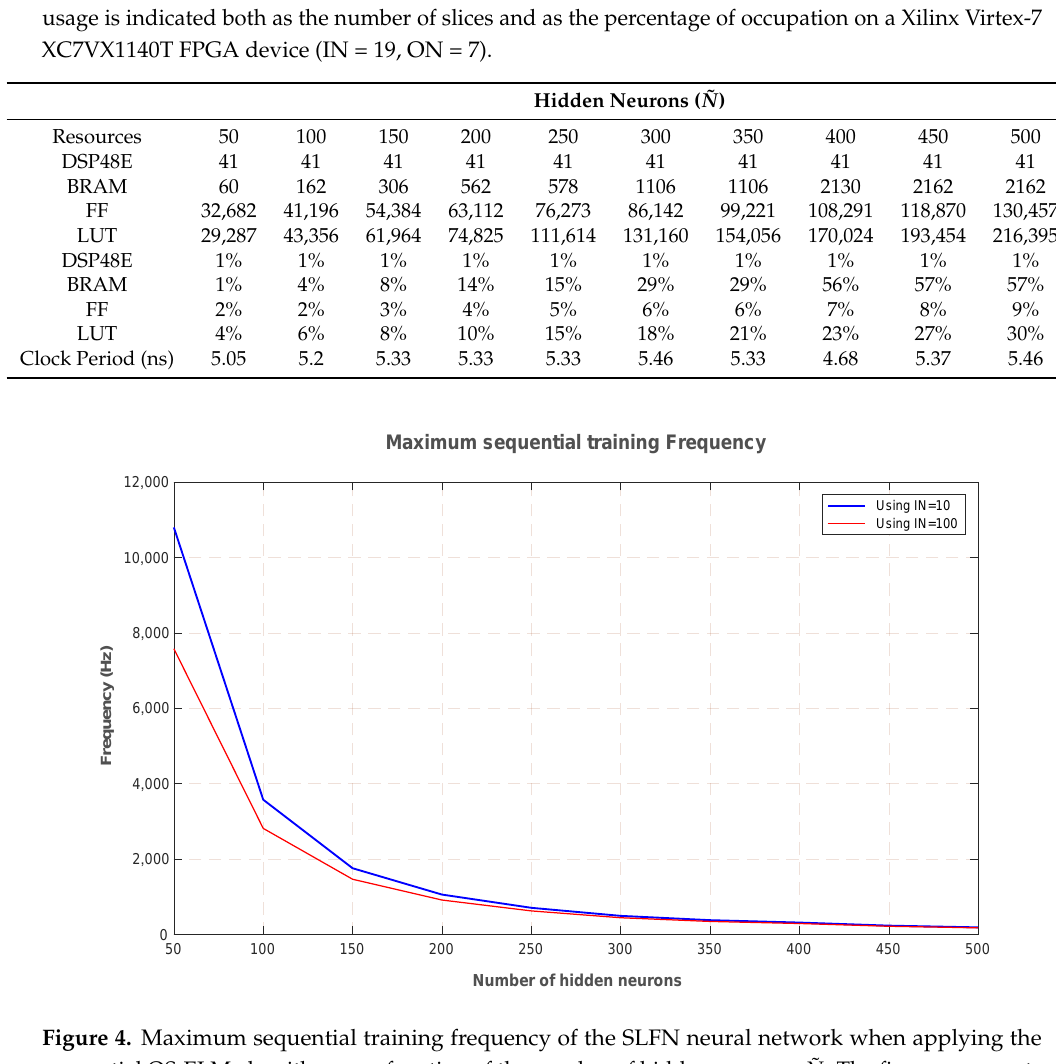
Figure 4. Maximum sequential training frequency of the SLFN neural network when applying the sequential OS-ELM algorithm, as a function of the number of hidden neurons, ˜ N . The figure represents the case of SLFNs with 10 and 100 input neurons (blue and red